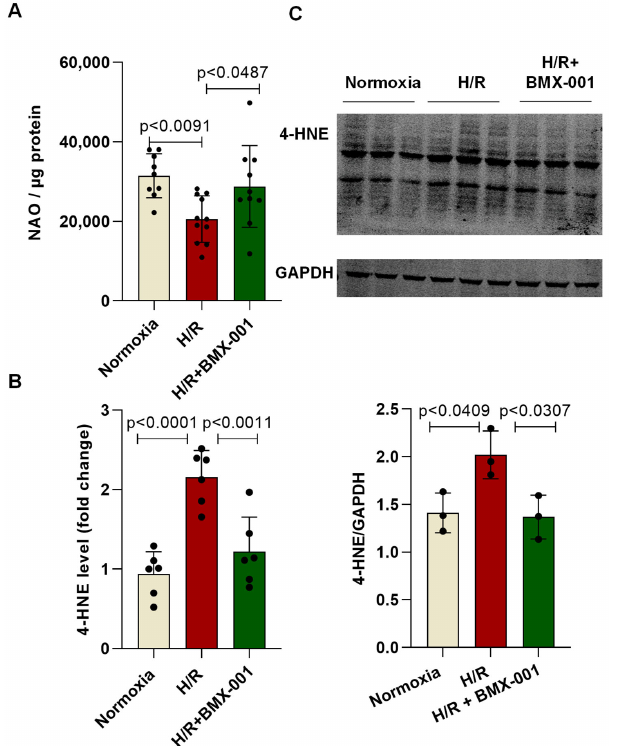
Figure 3. Redox regulator, BMX-001 attenuated lipid peroxidation and reactive aldehyde generation following H/R injury in H9c2 cells ( A ) Mitochondrial membrane cardiolipin peroxidation was meas- ured by analyzing the decrease in fl uorescence of 10-N-nonyl-Acridin Orange NAO ( B ) Quanti fi ca- tion of 4-HNE by HPLC in H9c2 cell following H/R injury. ( C ) Western blot image of 4-HNE-ad- ducted protein versus loading control, GAPDH, is shown. All values are mean ± SD. The p- value was used to determine statistical signi fi cance compared to the control group. Di ff erences between the two groups were analyzed by the two-tailed Student’s t -test and of more than two groups by one-way ANOVA with post-hoc Bonferroni Multiple Comparison test.